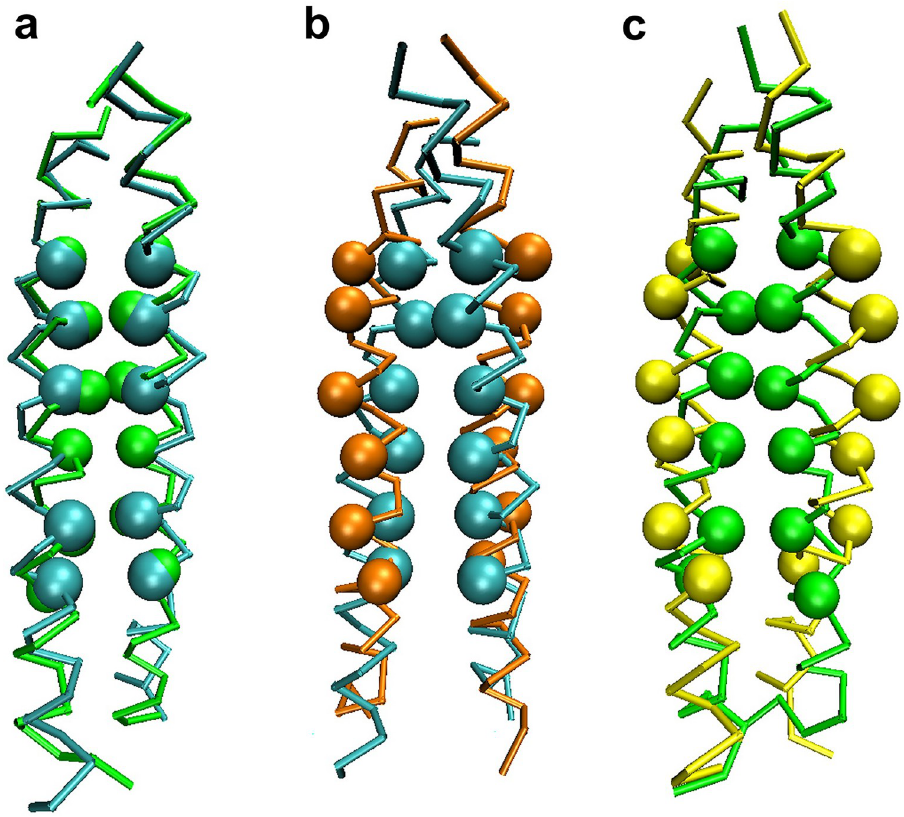
Fig 7. Superposition of the inactive and the active structures. (a) Superposition of the NMR (cyan) and the simulated (green) structures of inactive TMD. The traces represent the backbones and the spheres represent the residues L768, T771, A775, F778, L782, and I785, which form the interhelical contacting pairs in TMD. (b) Superposition of the NMR structures of the inactive (cyan) and the active (orange) TMD. (c) Superposition of the simulated structures of the inactive (green) and the active (yellow)